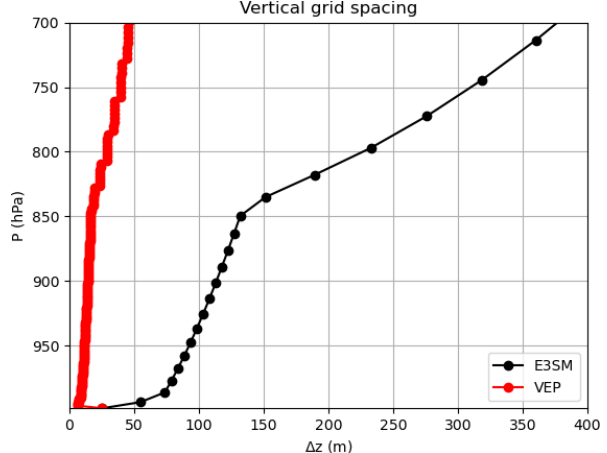
Figure 2. Estimated vertical grid spacing for the vertical grid used in E3SM (black curve) and for the vertically enhanced physics (VEP) used in the FIVE simulations in this